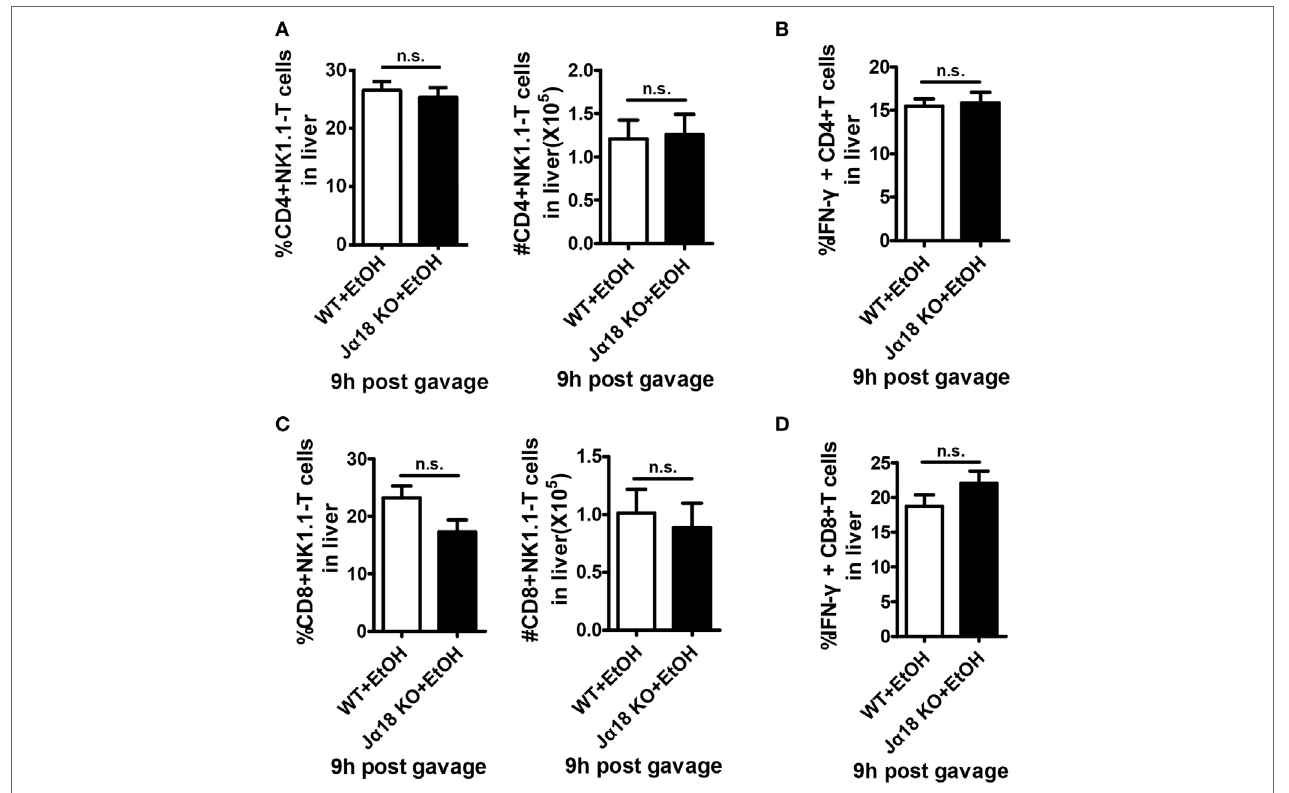
FigUre 7 | The numbers and interferon- γ (IFN- γ ) release of hepatic CD4 + and CD8 + T cells are not changed in J α 18 KO mice when exposed to ethanol. Wild-type or J α 18 KO mice were fed ethanol diets for 10 days, followed by gavage as described in Figure 1 . The mice were sacrificed 9 h after gavage, and liver mononuclear cells were then isolated. The percentages, absolute numbers, and IFN- γ release levels of (a,B) CD4 + T cells and (c,D) CD8 + T cells among all leukocytes in the liver were detected by flow cytometry and were statistically analyzed. The data are representative of more than three independent experiments and are shown as the mean ± SEM ( n = 3–6).